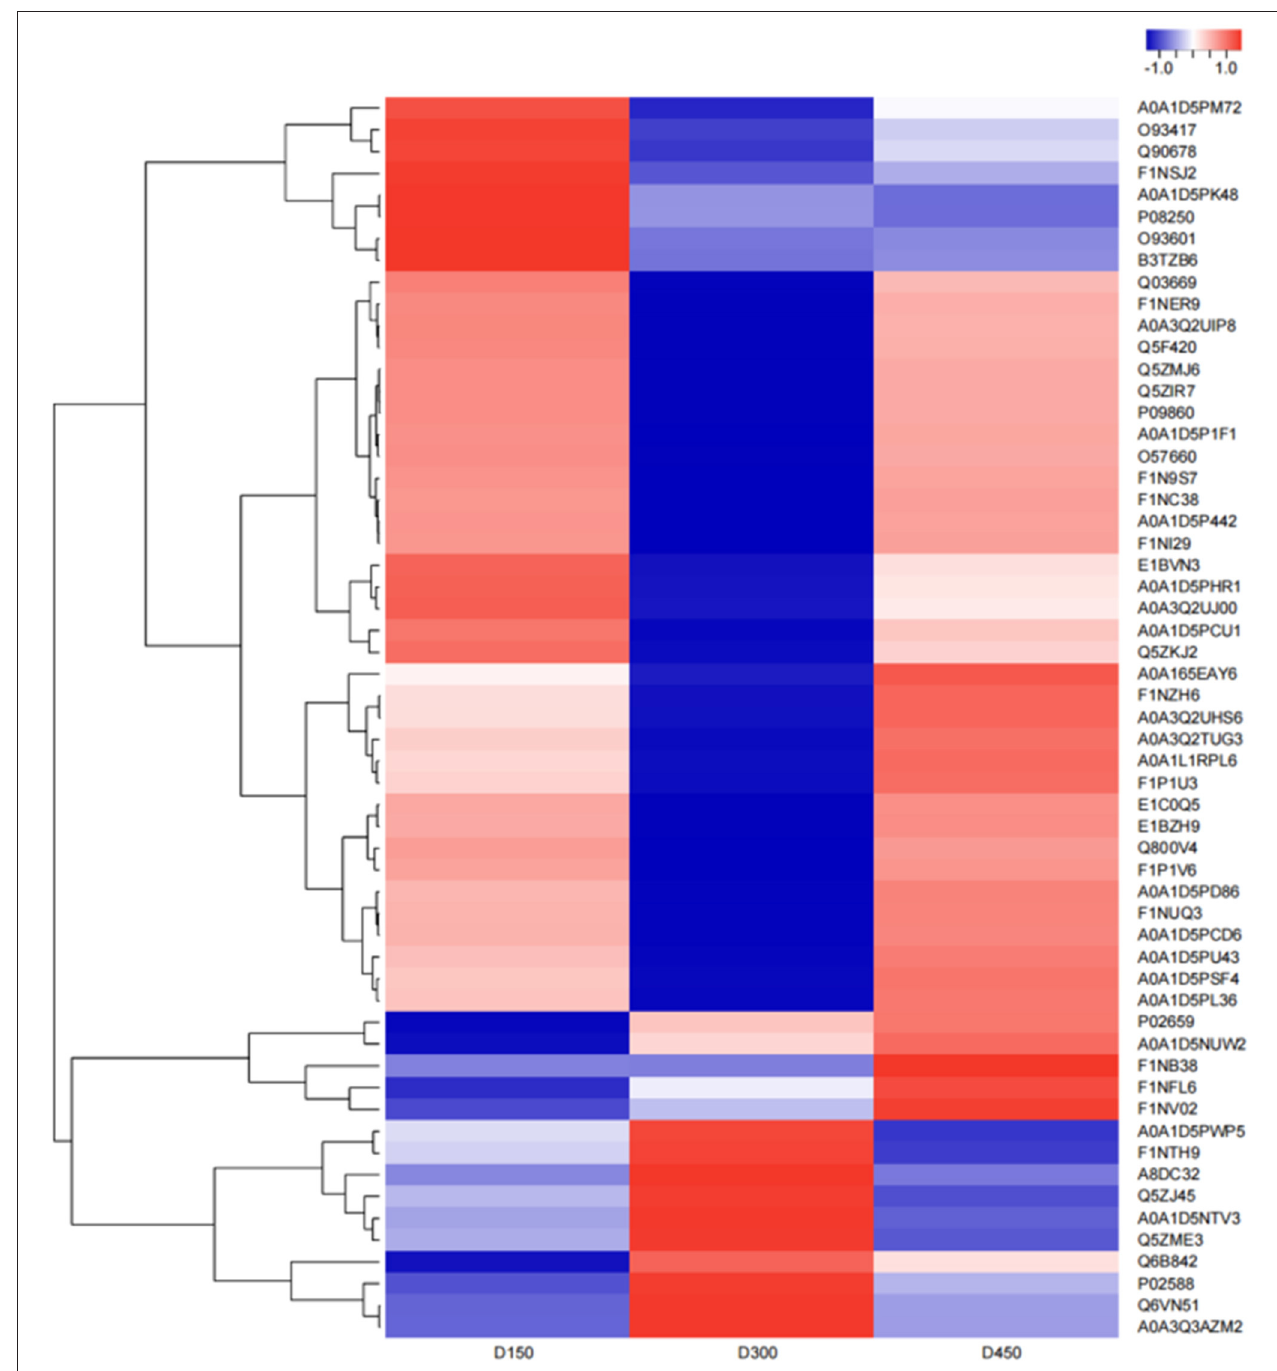
FIGURE 6 | Heatmap of the 57 differentially expressed proteins related to fatty acid metabolism in the three different chronological ages (D150, D300, and D450) of breast muscle. Blue indicates downregulation, red indicates upregulation, and white indicates undetectable in the heat map.